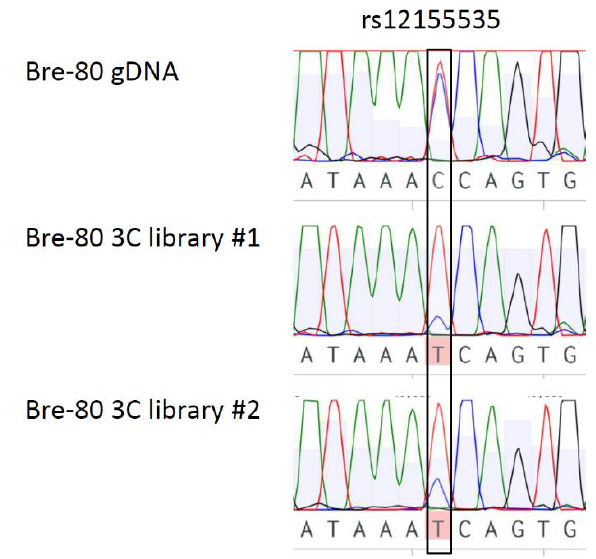
Figure 3. Allele-specific interaction between PRE2 and the DUSP4 promoter region. Bre-80 cells are heterozygous for the rs12155535 CCV in PRE2. Allele-specific analysis using PCR-based Sanger sequencing of two independent 3C libraries indicated that sequence containing the protective (T) allele of rs12155535 preferentially interacted with the DUSP4 promoter region.